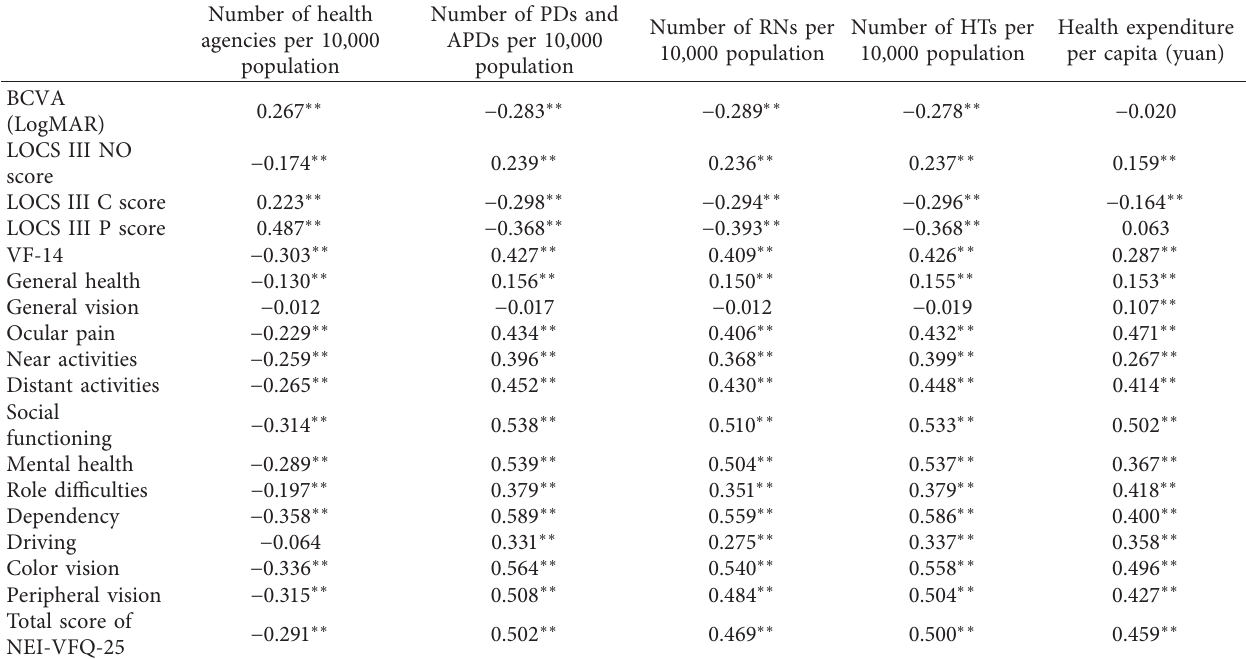
Figure 2: Change in subjective questionnaire scores with the rank of per capita disposable income (PCDI). VF-14, Visual Function Index- 14; NEI-VFQ-25, 25-item National Eye Institute Visual Functioning Questionnaire. Table 2: Correlations of the medical and healthcare services with subjective and objective measurements ( n �